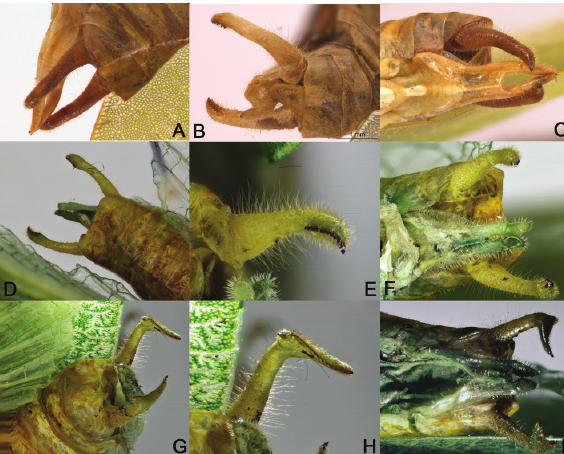
Figure 3. Morphological details of male Gonatoxia species. A–C. G. maculata , apex, semilateral view ( A ), dorsal view on cerci and apex ( B ), subgenital plate ( C ) D–F. G. immaculata , dorsal view on apex ( D ), right cercus ( E ), subgenital plate ( F ) G–I. G. furcata sp. n., semilateral view on apex ( G ), left cercus ( H ) and subgenital plate ( I ).